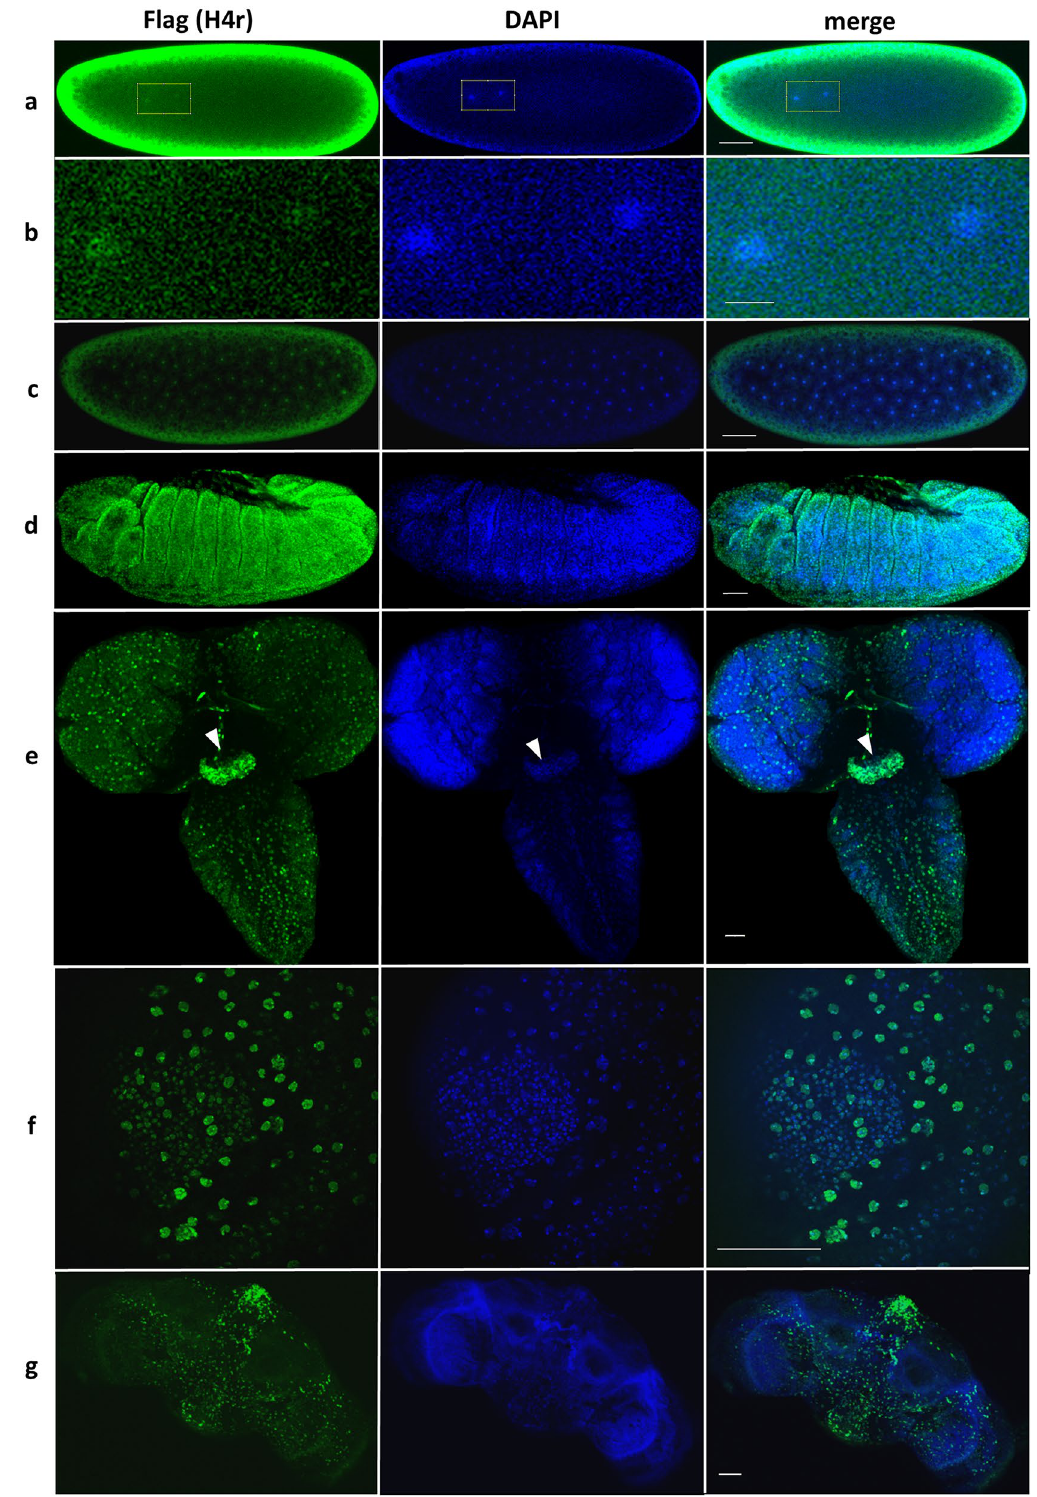
Figure 1. Expression of H4r in embryo and brains of larvae and adults. ( a ) Fertilized embryo; Framed inlet highlights pronuclei; ( b ) Pronuclei; ( c ) Early embryo (nc 7); ( d ) Gastrulating embryo; ( e ) Larval brain (eye discs and ventral nerve cord, arrowhead: suboesophagial ganglion); ( f ) Eye disc; ( g ) Adult brain. Scalebars refer to 50 µm on ( a, c ), ( d-g ), 10 µm on ( b